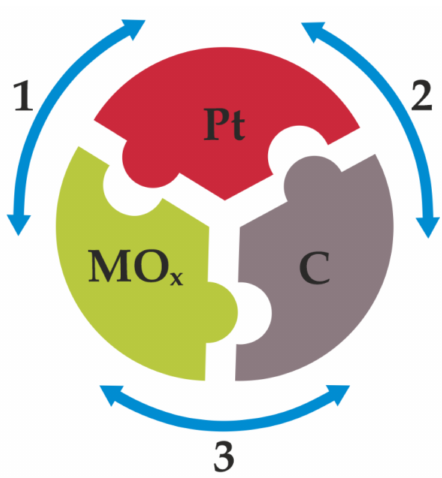
Figure 1. Schematic diagram emphasizing the importance of mutual interactions (marked with arrows: 1, 2, and 3, respectively) between catalytic platinum, carbon support (carrier), and metal oxide additive (cocatalyst). To explain electrocatalytic enhancement effects, we refer graphically to “the lock and key” model, explaining the specificity of enzymes. It can be rationalized that specific (activating and stabilizing) interactions should exist not only between the metal (Pt) and support (carbon carrier), but also between these components and the metal oxide cocatalyst. Likewise, enzymes, the active nanostructures, should be “flexible” and undergo some changes (e.g., structural, chemical), possibly including self-healing (e.g., through interactions with the corrosion-suppressing metal